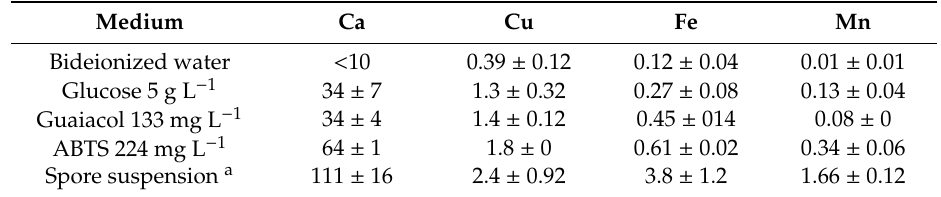
Table 1. Mean concentrations ( µ g L − 1 ± SD; n = 2) in the high-purity incubation media of metal cations which are commonly associated with laccase and MnP metalloenzymes (ICP-MS data).